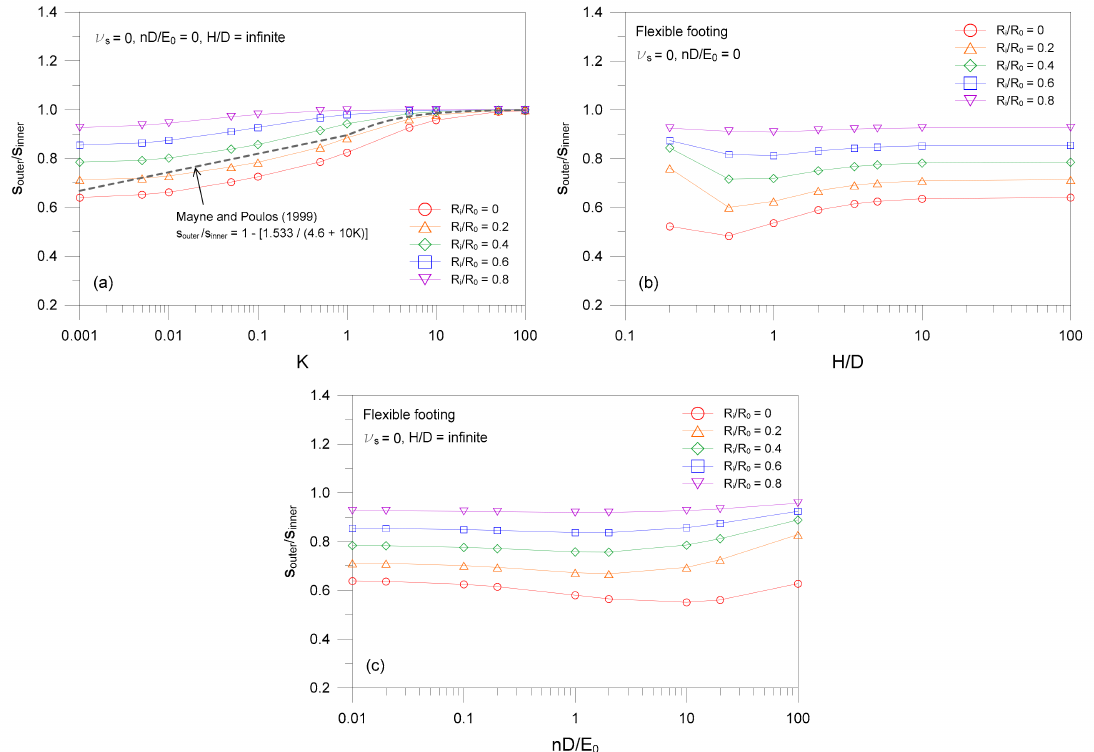
Figure 8. Variation of s outer / s inner with respect to footing stiffness, finite layer thickness ratio and modulus inhomogeneity: ( a ) effect of K ; ( b ) effect of H / D ; ( c ) effect of nD / E 0